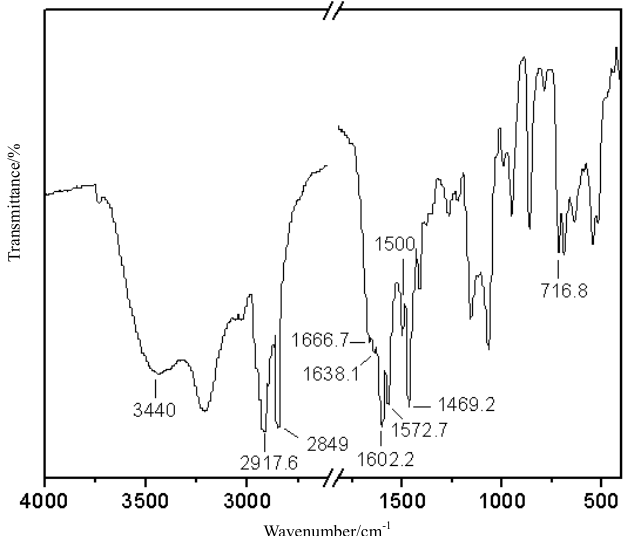
Figure 1. FT-IR spectra of N -(benzoyl) stearic acid